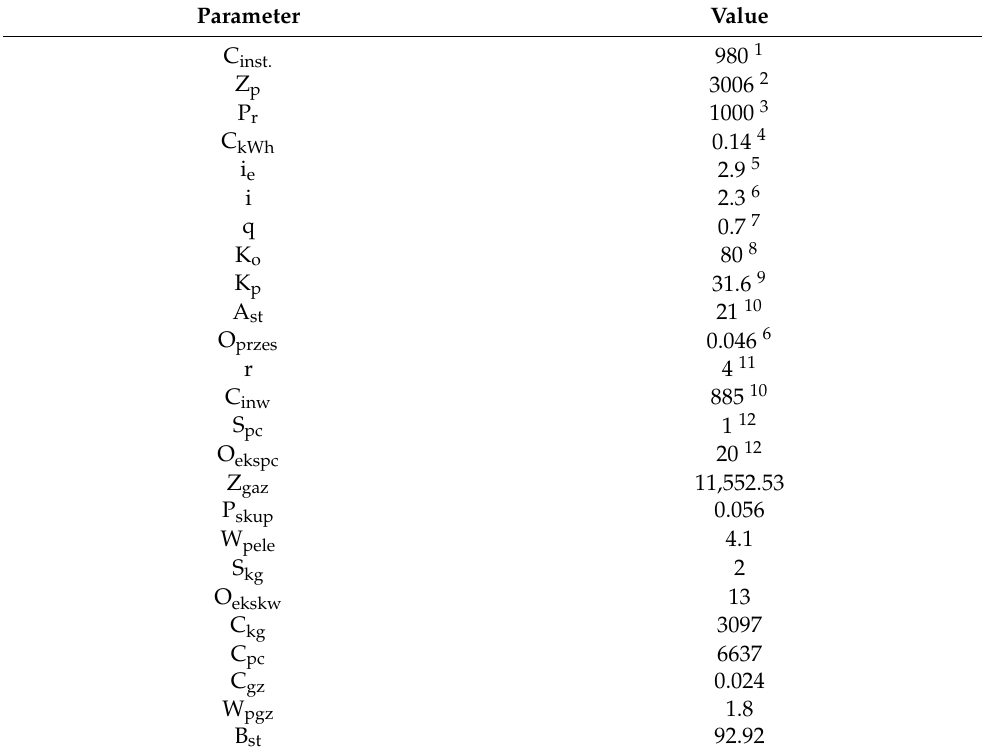
Table 4. Detailed assumptions for the conducted profitability